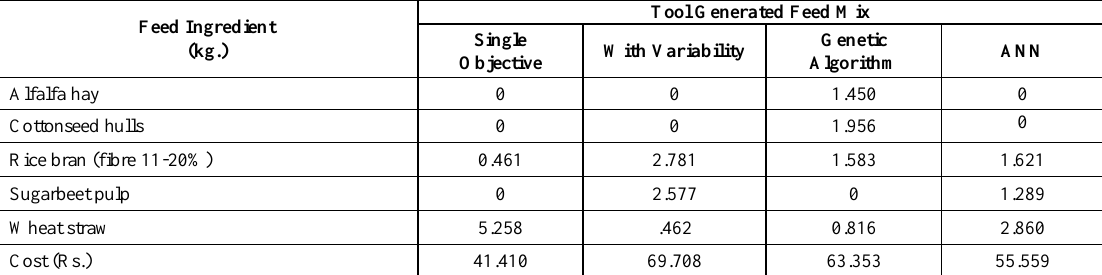
Table 2. Results of cost minimization for dairy cattle feed mix Feed Ingredient